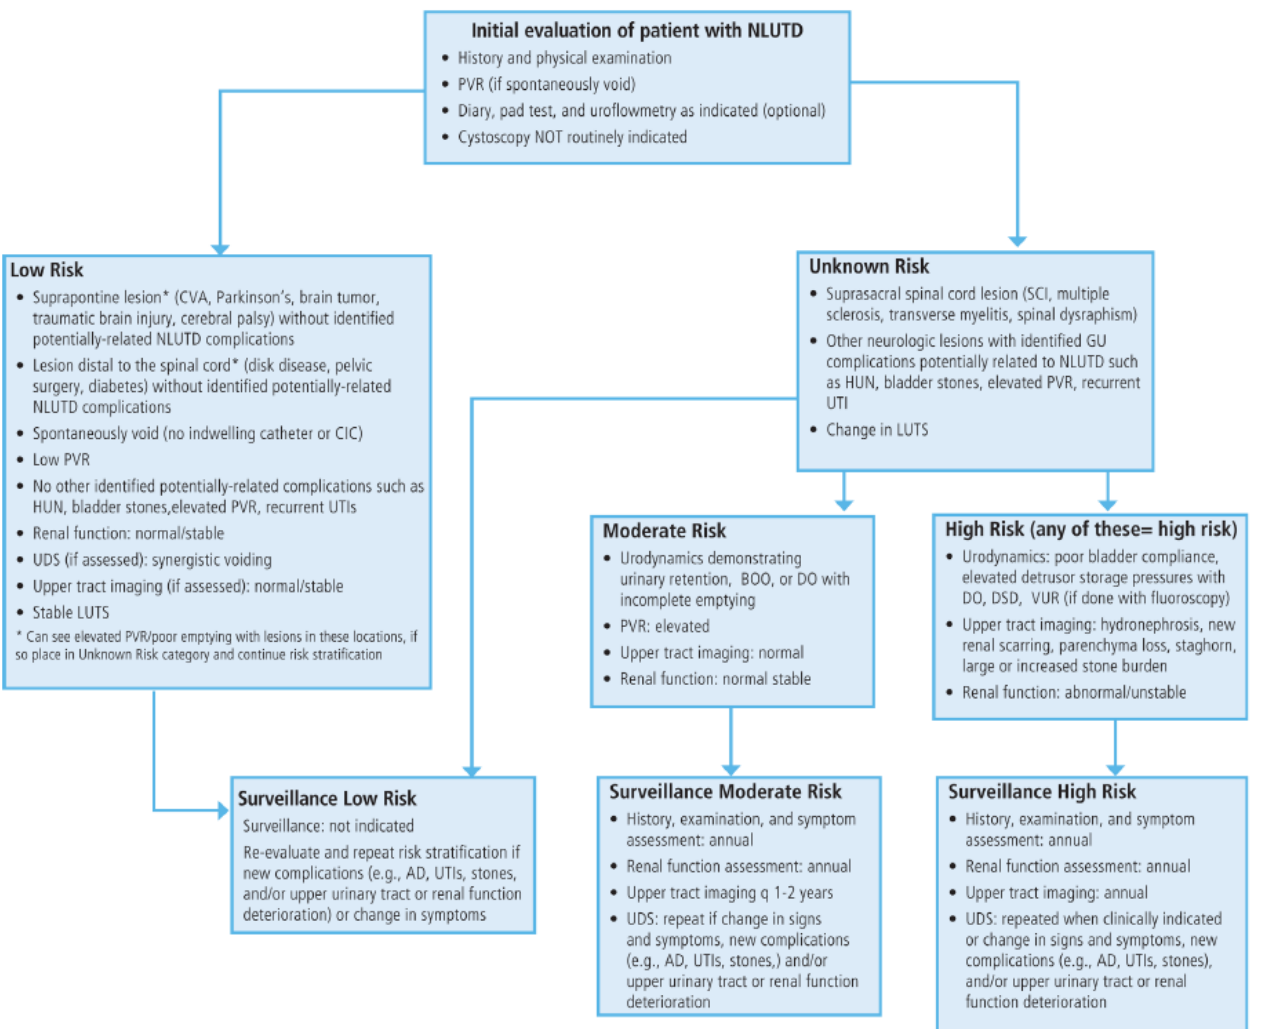
Figure 2. AUA/SUFU neurogenic lower urinary tract dysfunction risk stratification flow chart. Adapted with permission from Ref. [15]. 2021, Ginsberg et al.